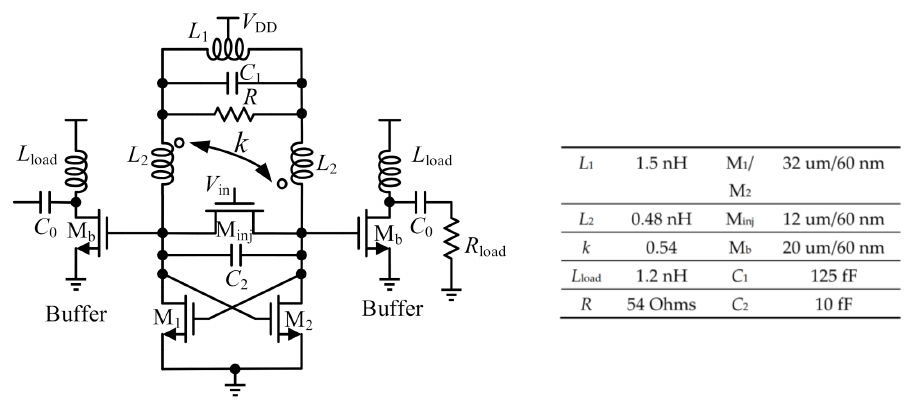
Figure 9. Circuit implementations of the proposed